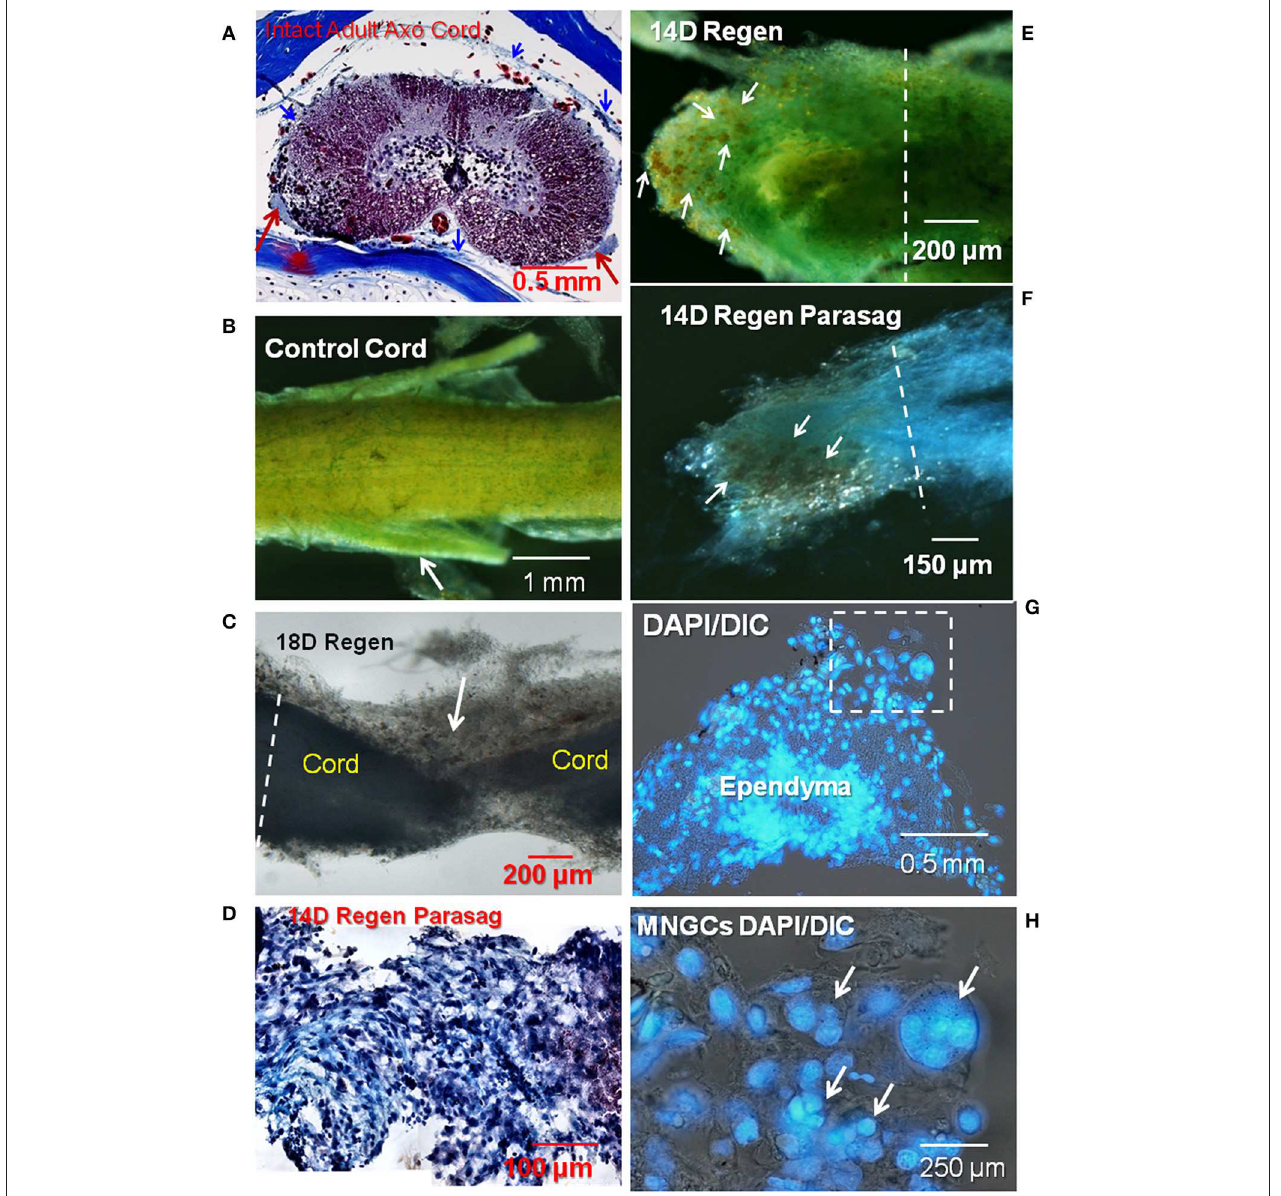
FIGURE 1 | Collagen and proteoglycan stains in regenerating and control adult axolotl spinal cord. (A) A cross-section of intact adult axolotl spinal cord labeled with trichrome stain. Red arrows show denticulate ligaments, a pial extension stained with aniline blue (collagen). Thin meningeal layers are present, collagen stained blue (blue arrowheads). (B) Spinal cord wholemount labeled with mentanil yellow (collagen) and alcian blue (acidic proteoglycans). Arrow shows a nerve root. (C) Unstained lesioned cord regenerated for 18 days, backlit stereoscopic view. Arrow shows a mass of ECM that joins the proximal and distal regenerating stumps. (D) Parasagittal paraffin section through 14D regenerating cord stained with trichrome. (E) Mentanil yellow and alcian blue label in 14D regenerating cord. The arrows indicate lipid-laden cells that appear orange against the stained ECM. (F) Regenerating spinal cord stained with alcian blue and the tissue dissected in the parasagittal plane. Lipid-laden cells in the fibrotic ECM are indicated by arrows. (G) Paraffin sections of a regenerating 14D cord with DAPI nuclear label. Stump region with reactive meninges. Dashed square indicates area at higher magnification in (H) . (H) DAPI-labeled nuclei in 14D regenerating cord. Arrows show a group of multinucleated cells present in the meninges. The white dashed lines in (C,E,F) indicate the site margin of harvested tissue for explants culture. Axo, axolotl; Regen, regenerating; Parasag, parasaggital; D, day; DIC, differential interference contrast. Magnification bar is shown in the lower portion of each image.